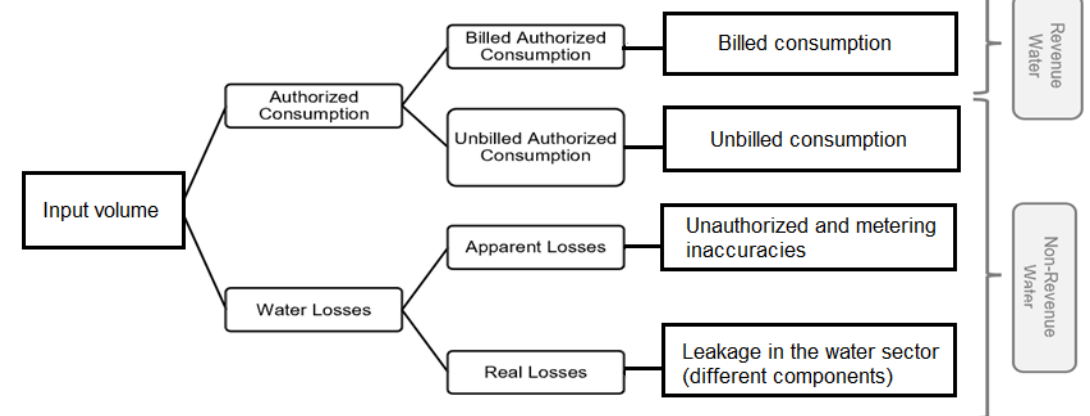
Figure 1. Typical water balance components.